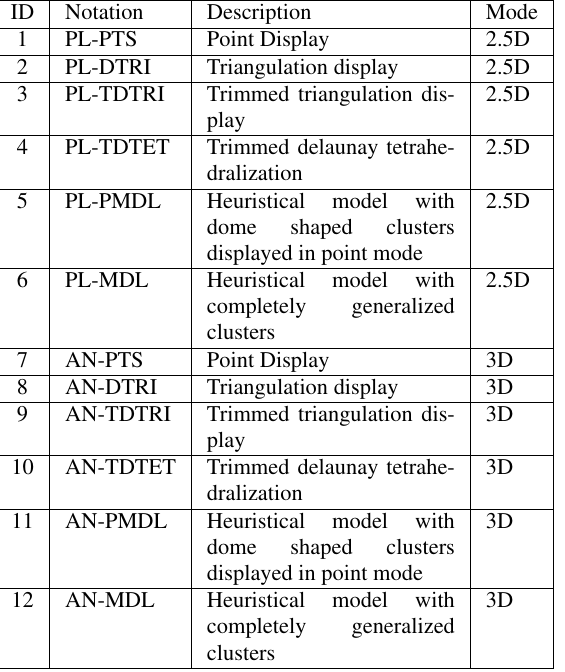
Table 1: Processing methods and their notations